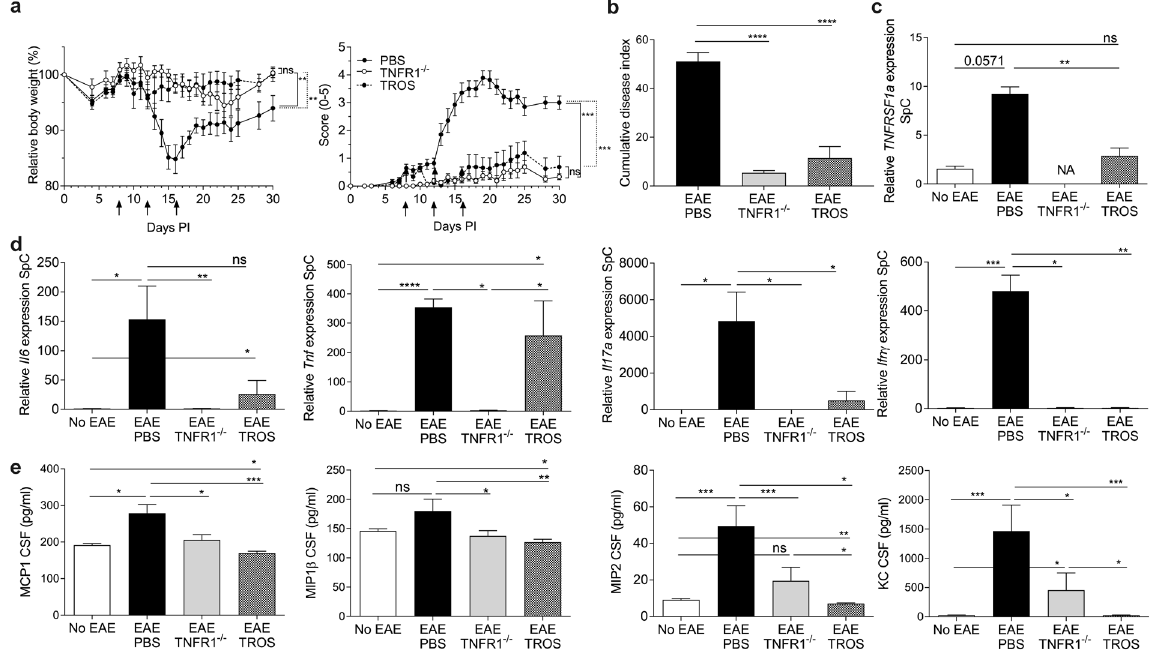
Figure 4. ( a – e ) EAE remission is induced in mice that are therapeutically treated with TROS. hTNFR1 transgenic (Tg) and TNFR1 − / − mice were immunized with MOG 35-55 -peptide and pertussis toxin to induce EAE. hTNFR1 Tg mice with ongoing EAE were divided in balanced groups and therapeutically treated with 500 µ g TROS or PBS, e.g . at disease onset in all mice (day 8 post-immunization (PI)), injected intraperitoneally (i.p.). In ( a,b ) the treatment was repeated on day 12 and 16 PI. Mice were weighed and clinically scored daily. In c-e , mice were treated on day 8 and 12 (clinical scores are not shown) and mice were sacrificed at day 16 PI. Spinal cords (SpC) and CSF were isolated. (a,b ) Relative body weight ( a , left, relative to initial body weight) and clinical scores (scale 0 ‒ 5) ( a , right) were assessed until 30 days PI. ( b ) Cumulative disease index determined 30 days PI in all mice. (PBS n = 7; TROS n = 9; TNFR1 − / − n = 8). (c–d ) Relative gene expression of Tnfrsf1a ( c ), Il6 , Tnf, Il17a and Ifn γ ( d ) was determined with qPCR in spinal cords of healthy hTNFR1 Tg (no EAE, n = 4), EAE TNFR1 − / − mice (n = 5) and hTNFR1 Tg mice treated twice with TROS (n = 4) or PBS (n = 5) (day 8 and 12 PI) isolated 16 days PI. ( e ) Chemokines MCP1, MIP1 β , MIP2 and KC were determined in the cerebrospinal fluid (CSF) of healthy hTNFR1 Tg mice (no EAE, n = 7), EAE TNFR1 − / − (n = 7) and hTNFR1 Tg mice treated twice with TROS (n = 8) or PBS (n = 8) (on day 8 and 12 PI), 16 days PI. Data information: qPCR was normalized to stable housekeeping genes. Bars represent mean ± SEM. Clinical scores were analyzed as repeated measurements using the restricted maximum likelihood (REML) variance components analysis. Cumulative disease index and maximum score were compared with a one-way ANOVA, and all qPCR and Luminex data with a Mann-Whitney test. All experiments were performed twice and representative results were shown. * 0.01 ≤ p < 0.05; ** 0.001 ≤ p < 0.01; *** 0.001 ≤ p 0.0001, **** p < 0.0001. Non-statistically significant differences are not indicated on the graphs. NA = Not applicable